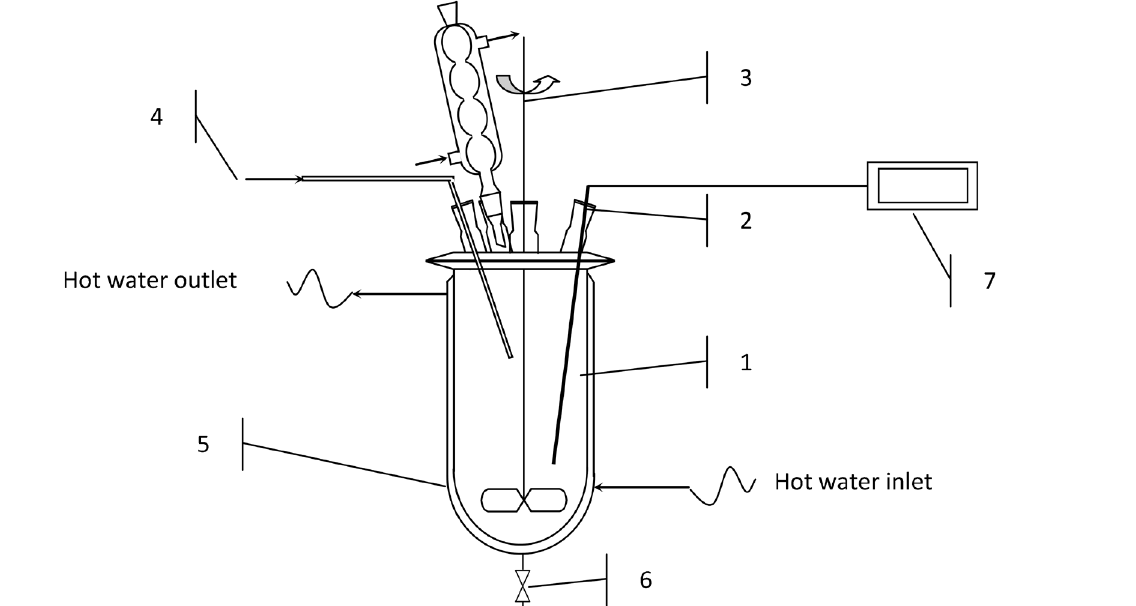
Figure 1: A schematic diagram of experimental apparatus: 1 – glass reactor V – 1,5 dm 3 , 2 – thermocouple, 3 – mechanical stirrer, 4 – inert gas inlet, 5 – water heating jacket, 6 – drain valve, 7 – temperature digital